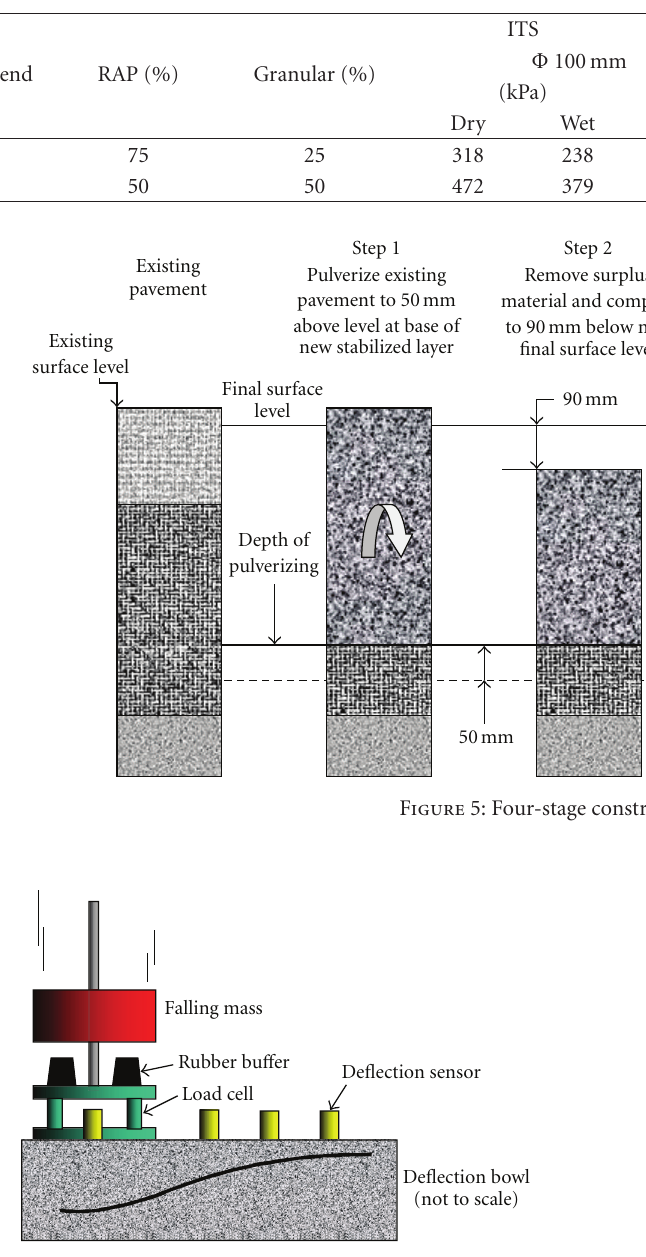
Figure 7: NTUA FWD system used for the